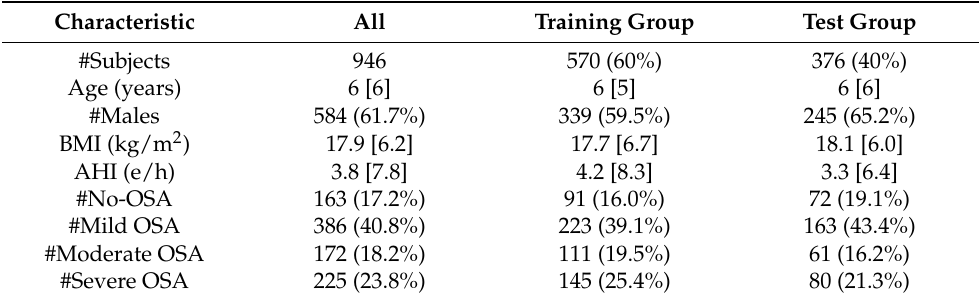
Table 1. Demographic and clinical characteristics of the different subject groups included during the training and testing phases of the